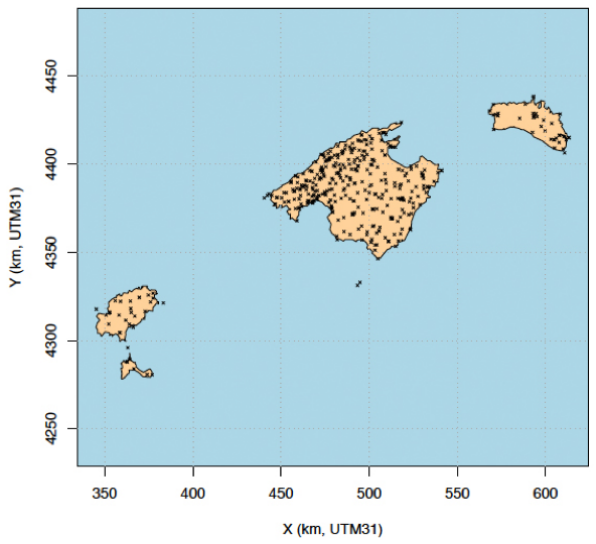
Figure 2. Position of the 418 rain-gauge stations of the AEMET at the Balearic Islands since